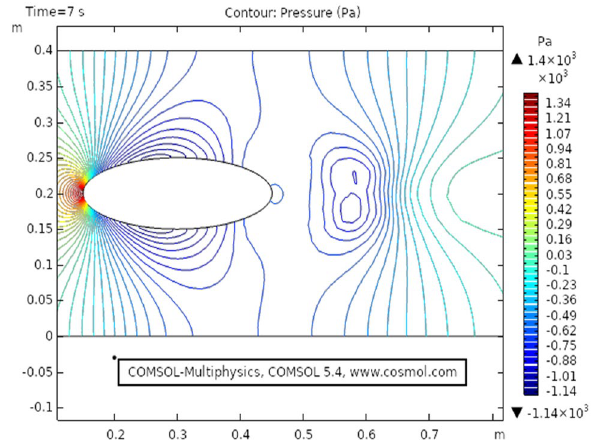
Figure 6. The pressure distribution in cylindrical elliptic flow at t = 7 s .